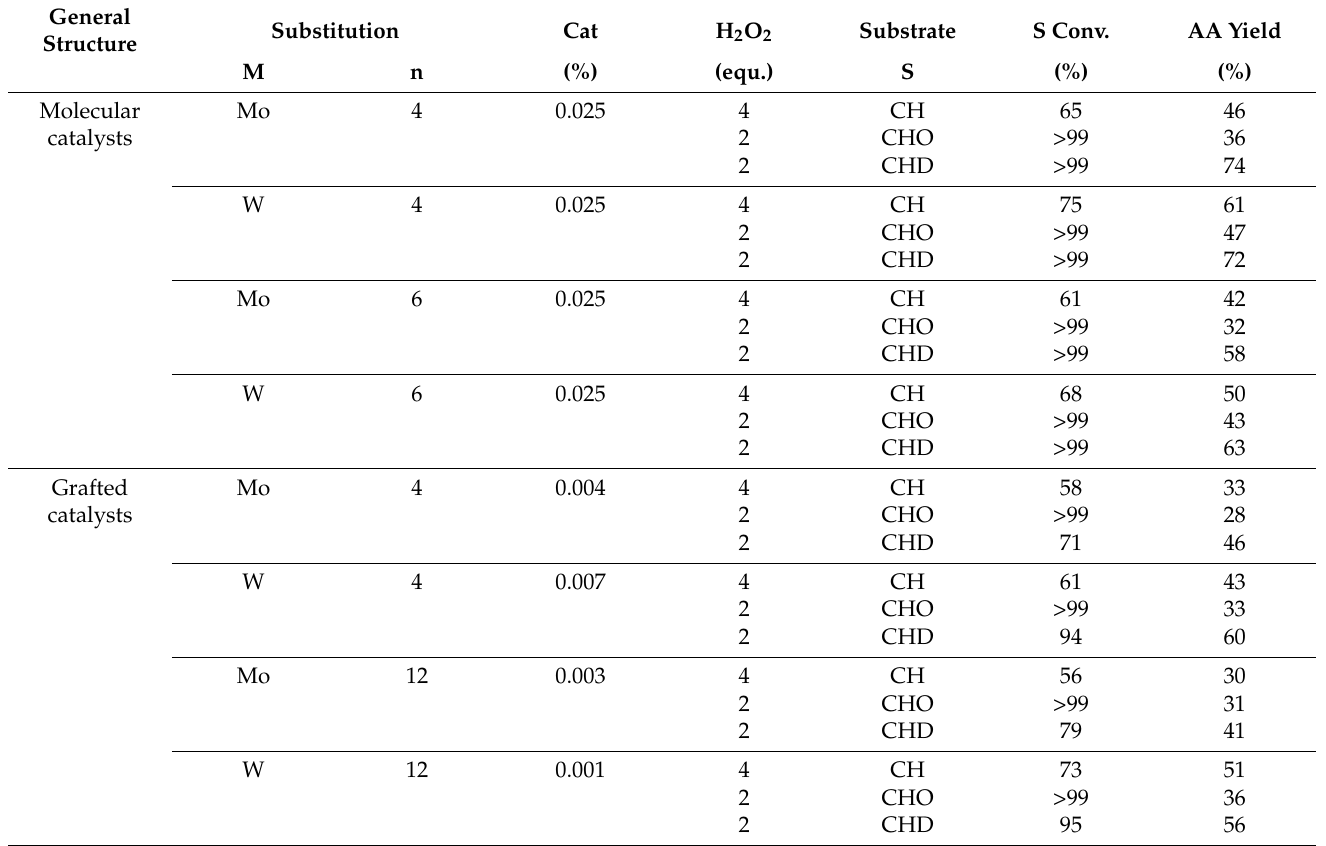
Table 12. Results of AA formation according to substrate using molecular of grafted POM-based catalysts from Figure